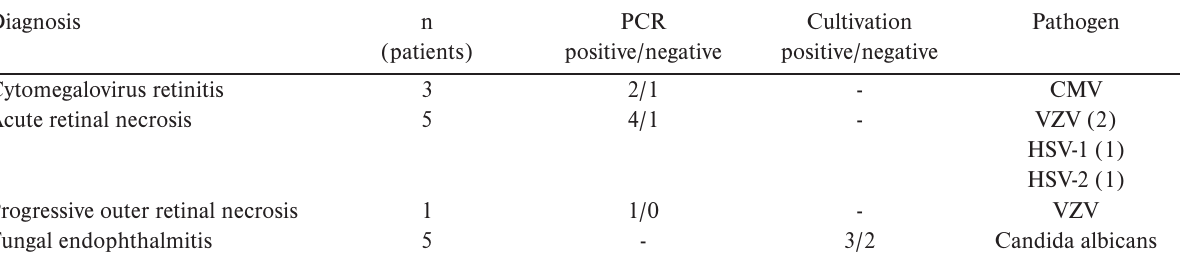
Table 2. Results of vitreous analyses in 14 patients indicated for pars plana vitrectomy.